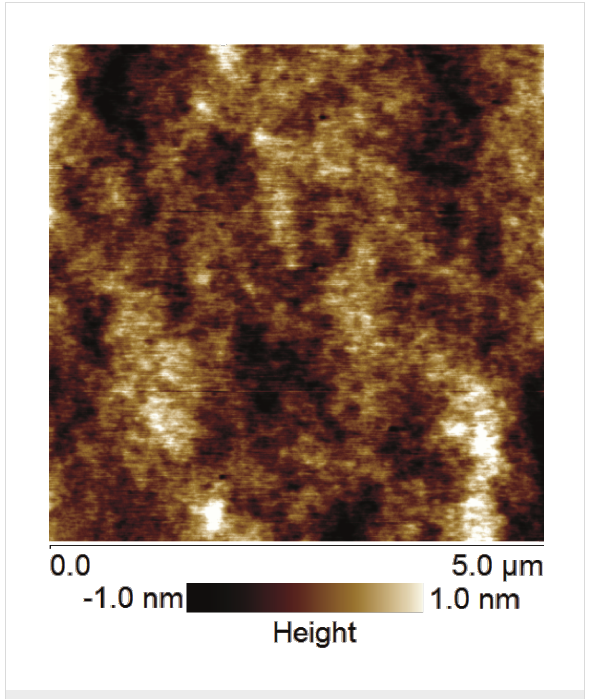
Figure 1: Topographic image of a typical PS-coated surface. The roughness average ( R a ) was 0.27 nm, the root mean square (RMS) was 0.35 nm, and the maximum peak-to-valley height of the image ( R max ) was 2.86